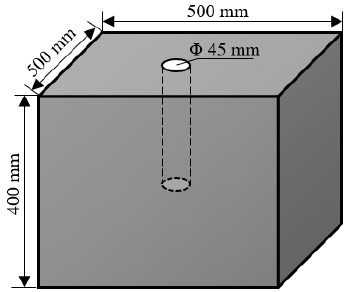
Figure 1. Concrete test block shell hole layout. Table 1. Types of test blocks.